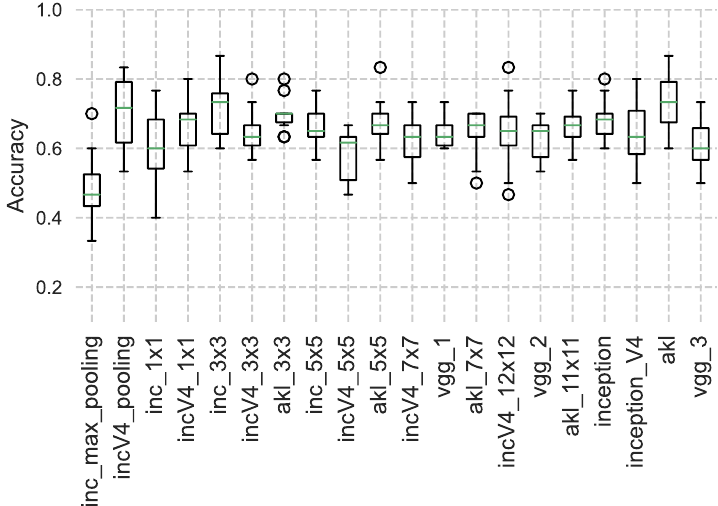
Figure 10. K-NN results using Horse vs Human dataset. The performance of the larger kernels, i.e. incV4_12 12 and akl_11 11, is low compared to the other kernels for the images of smaller size. ˆ ˆ